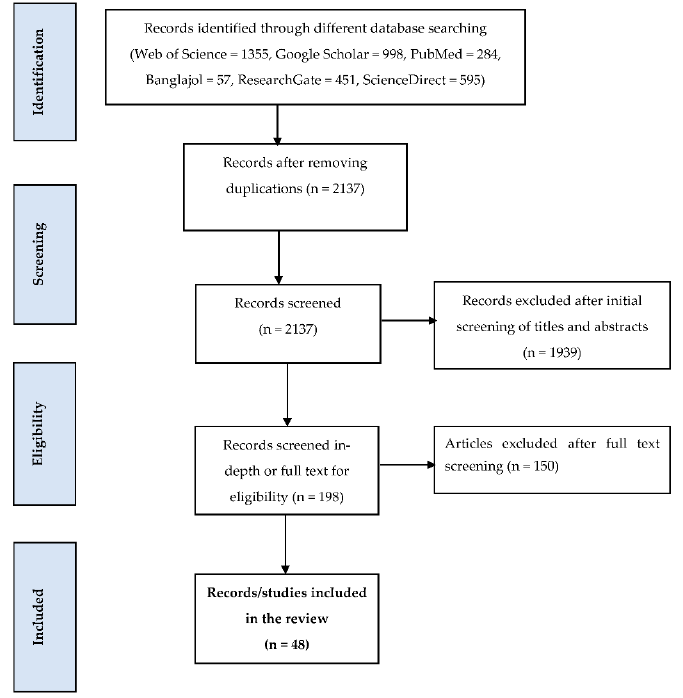
Figure 1. Selection process of the records.